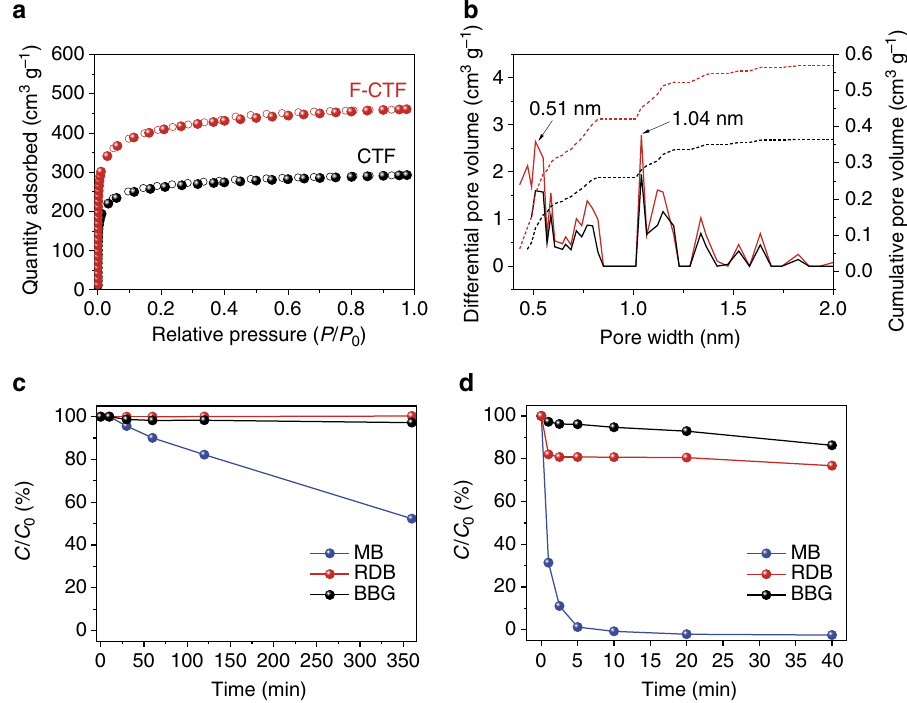
Figure 5 | Nanoporous CTFs as control structures with or without fluorines. ( a ) Argon adsorption–desorption isotherms of CTF and F-CTF measured at 87K, and ( b ) corresponding NLDFT pore size distribution. Change in dye concentrations over time after being treated by ( c ) CTF and ( d ) F-CTF. Initial concentration ( C 0 ) of the dyes was adjusted to be 50 m